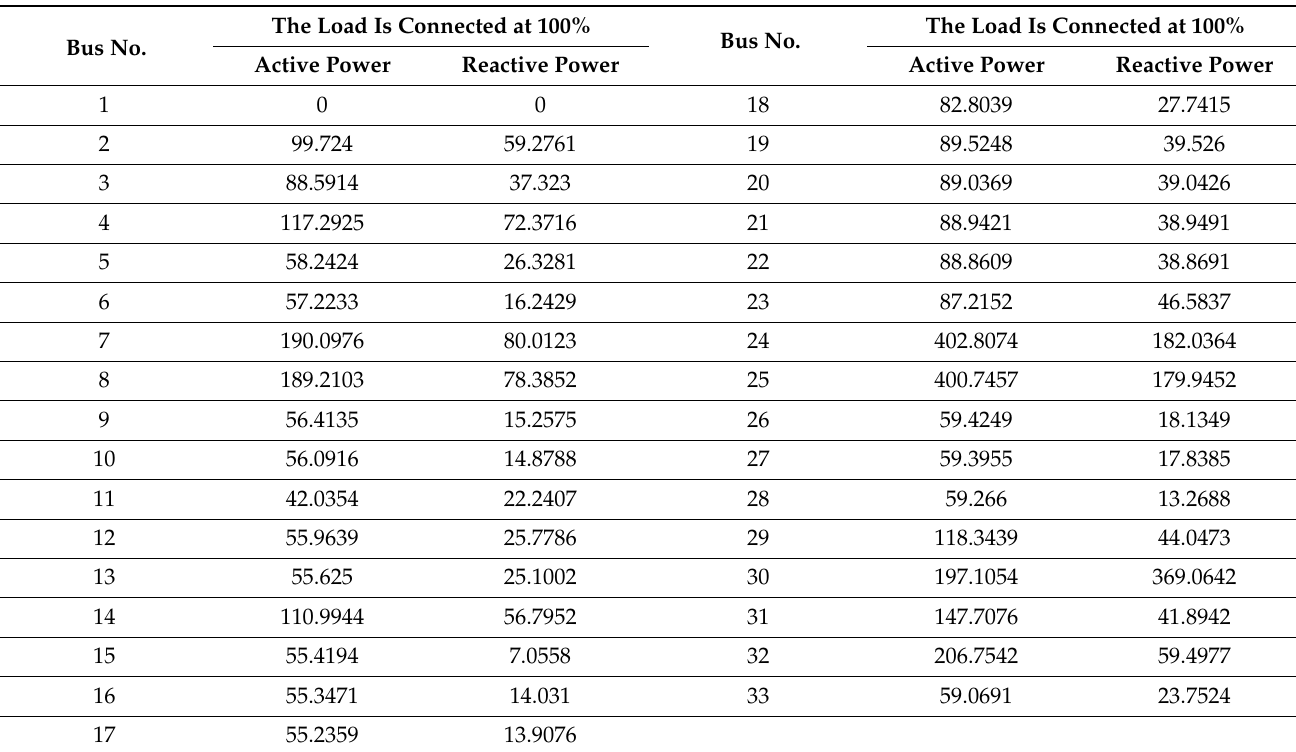
Table A2. The system load at 100% loading where the loads connected with nodes or buses for the IEEE 33-bus system. Bus